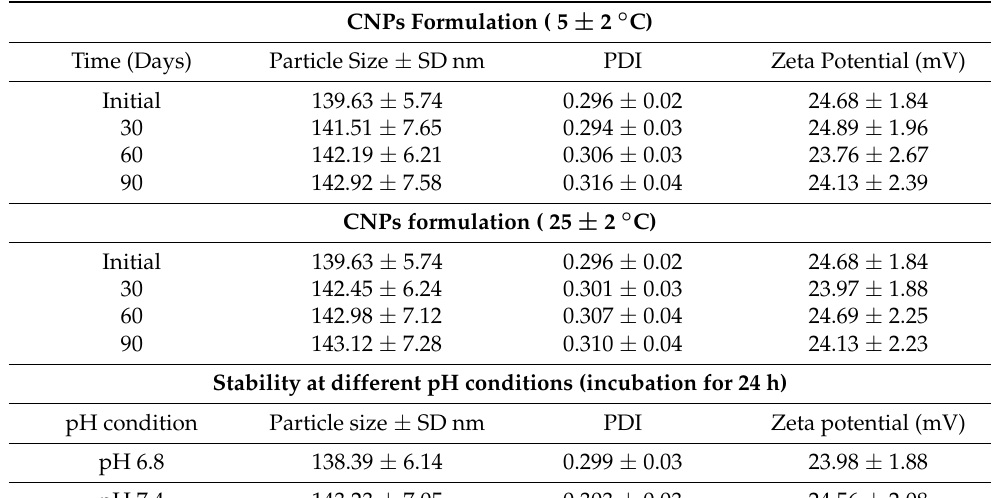
Table 6. Stability data.